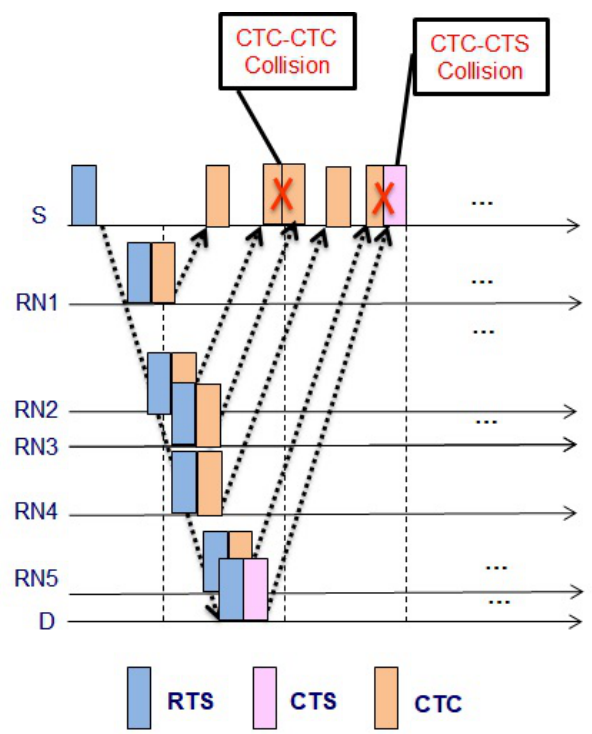
Figure 2. CTC-CTC and CTC-CTS